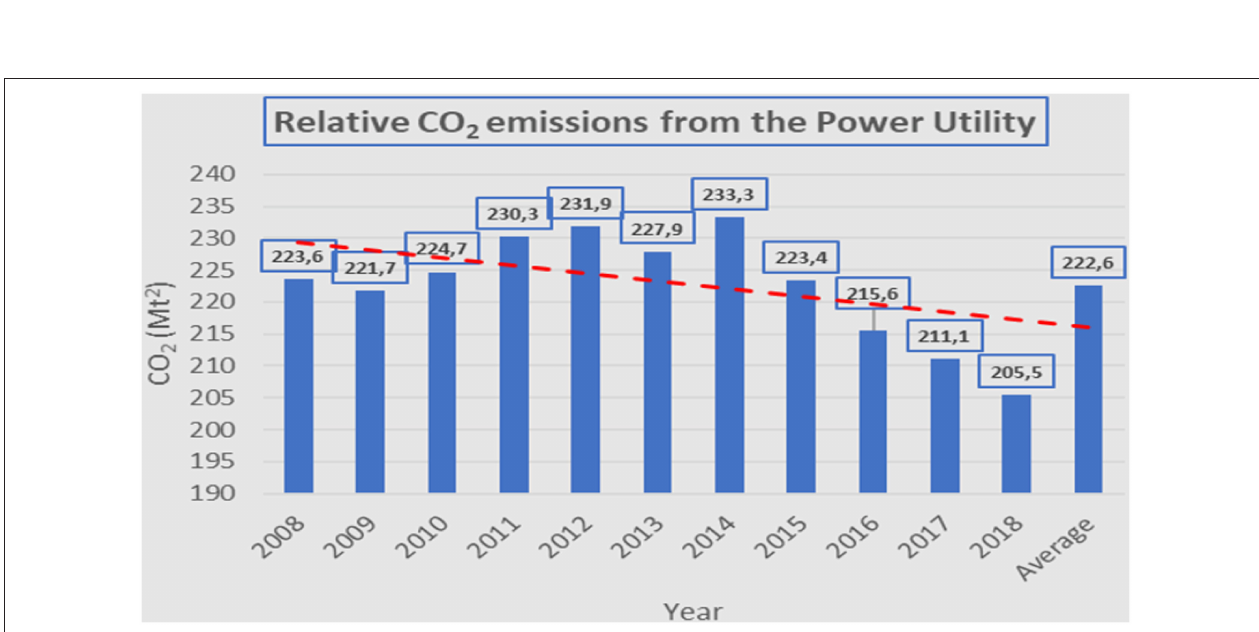
FIGURE 4 | Relative CO 2 produced during fuel-burning electricity generation. Source: Data from Eskom (2019).